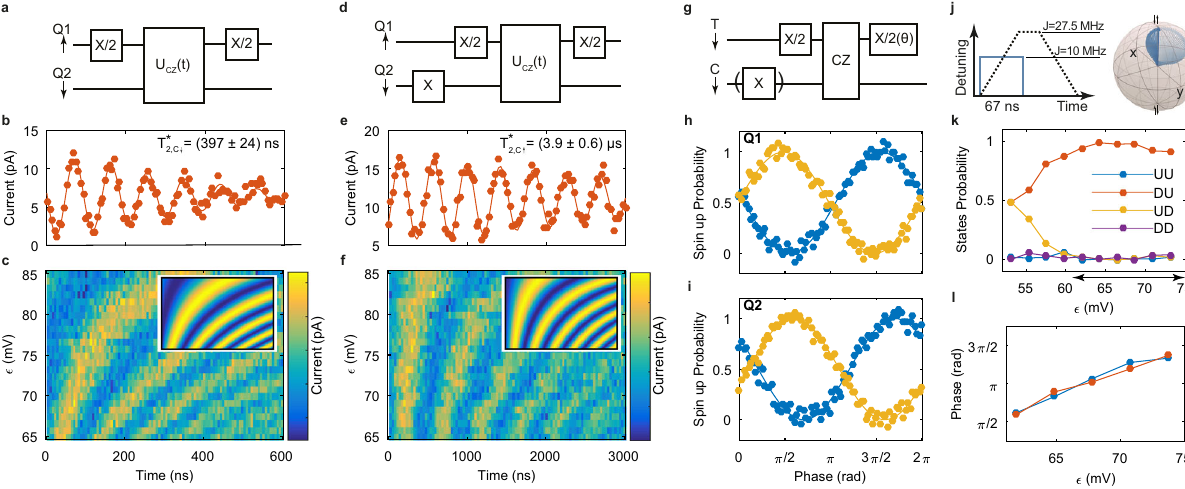
Fig. 2 Adiabatic and diabatic CPHASE operation at T = 1.05 K. Conditional phase oscillations ( b , c, e , f ) by adiabatically pulsing the detuning energy ϵ to increase the exchange interaction J , measured using the quantum circuit in a , d . The antiparallel spin states acquire a phase with respect to the parallel states, resulting in coherent oscillations as a function of the duration of the detuning pulse. At smaller detuning values, the exchange interaction increases resulting in faster oscillations. Due to the exchange interaction, the energy difference E ↓↑ − E ↓↓ (measured in b , c ) is smaller than E ↑↑ − E ↑↓ (measured in e , f ), resulting in an acquired phase on the target qubit (T) that is dependent on the state of the control qubit (C). g Schematic of the quantum circuit to verify CPHASE operation. The adiabatic detuning pulse of the CPHASE gate is tuned such that the antiparallel spin states acquire a total phase of 3 π . The exchange is increased to J = 27.5 MHz using a ramp t r = 60 ns and the total gate time is t CPHASE = 152 ns. h , i We verify CPHASE operation by measuring the normalized spin-up probability, obtained through conversion of the readout current, and observe clear antiparallel oscillations. j Schematic representation of an adiabatic (dashed black and shown in g – i and a diabatic (solid blue) CPHASE. k The diabatic CPHASE is optimized by changing the amplitude of ϵ and measuring probabilities of the four possible spin states. k , l The fi nite Zeeman difference ( Δ E z = 11 MHz) results in SWAP-interactions that are not negligible. However, the exchange can be tuned such that the states undergo rotations of 2 π . We tune and optimize this by measuring the phase, projected to the spin states through a π /2-pulse on the target qubit. We obtain a diabatic CPHASE for t CPHASE = 67